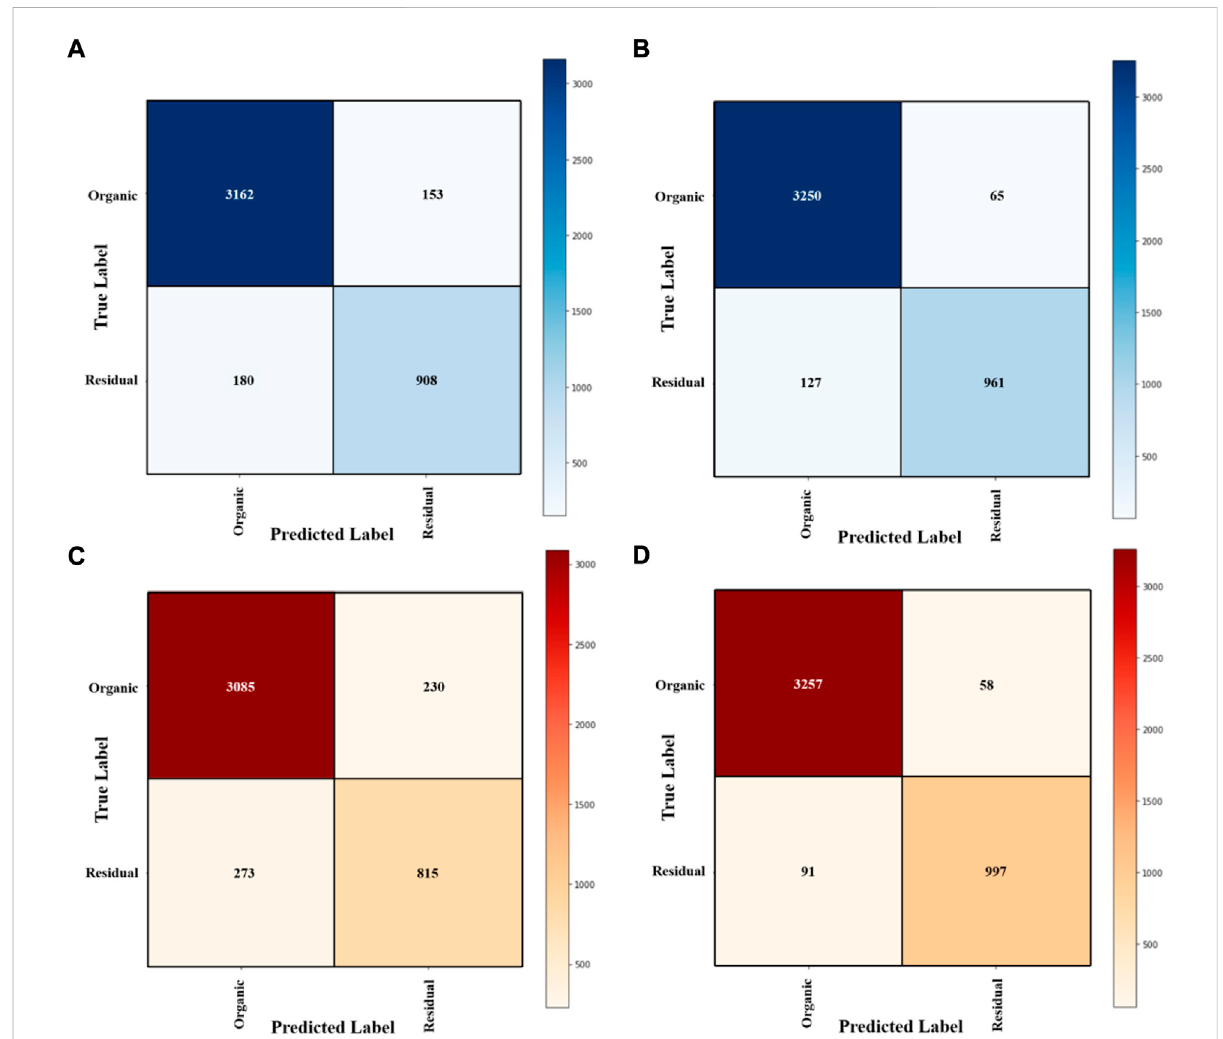
FIGURE 6 Confusion matrix from models runs on the test dataset: (A) VGGNet-16; (B) VGGNet-16 with TL; (C) ResNet-50; (D) ResNet-50 with TL; Note: TL was represented to transfer